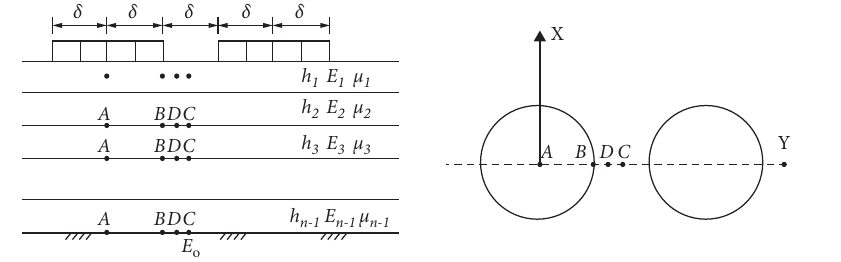
Figure 1: Compute point distribution. Table 1: Design index of pavements with different structures.